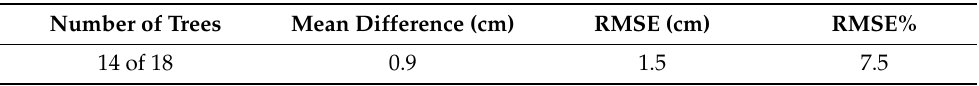
Table 3. Comparison of estimated DBH and field reference DBH. Mean difference and root mean squared error (RMSE).